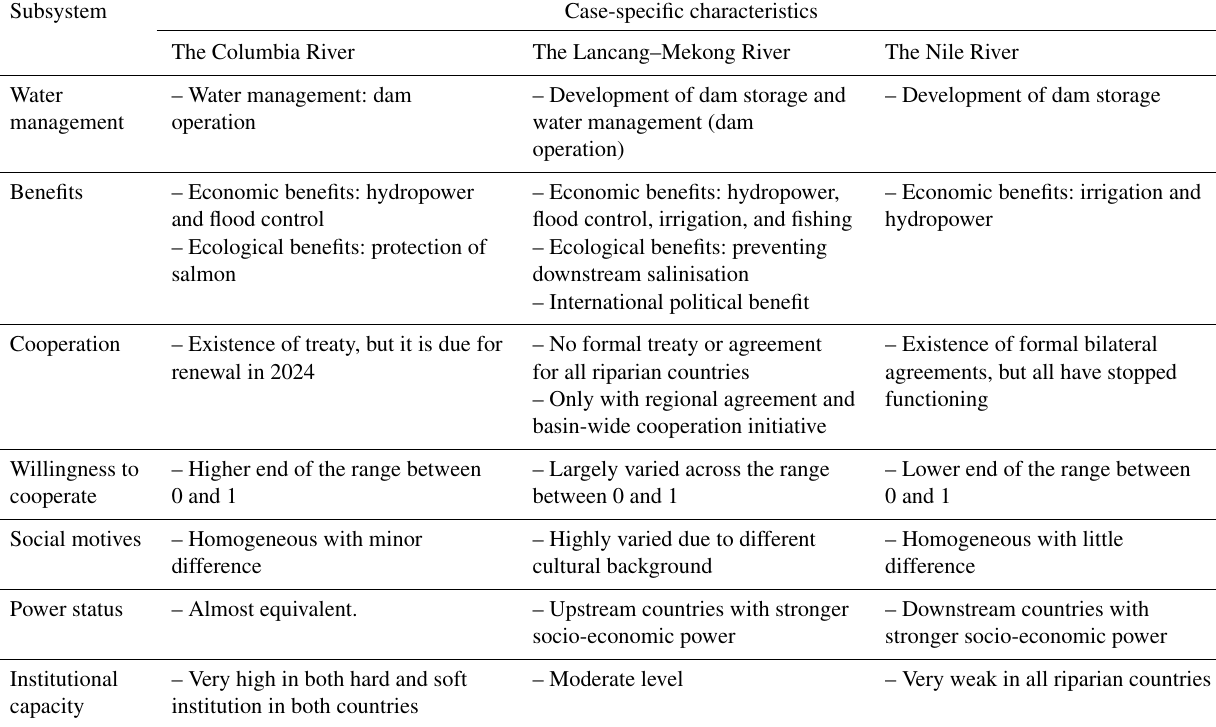
Table 3. Key subsystems of the three river case studies identified based on the